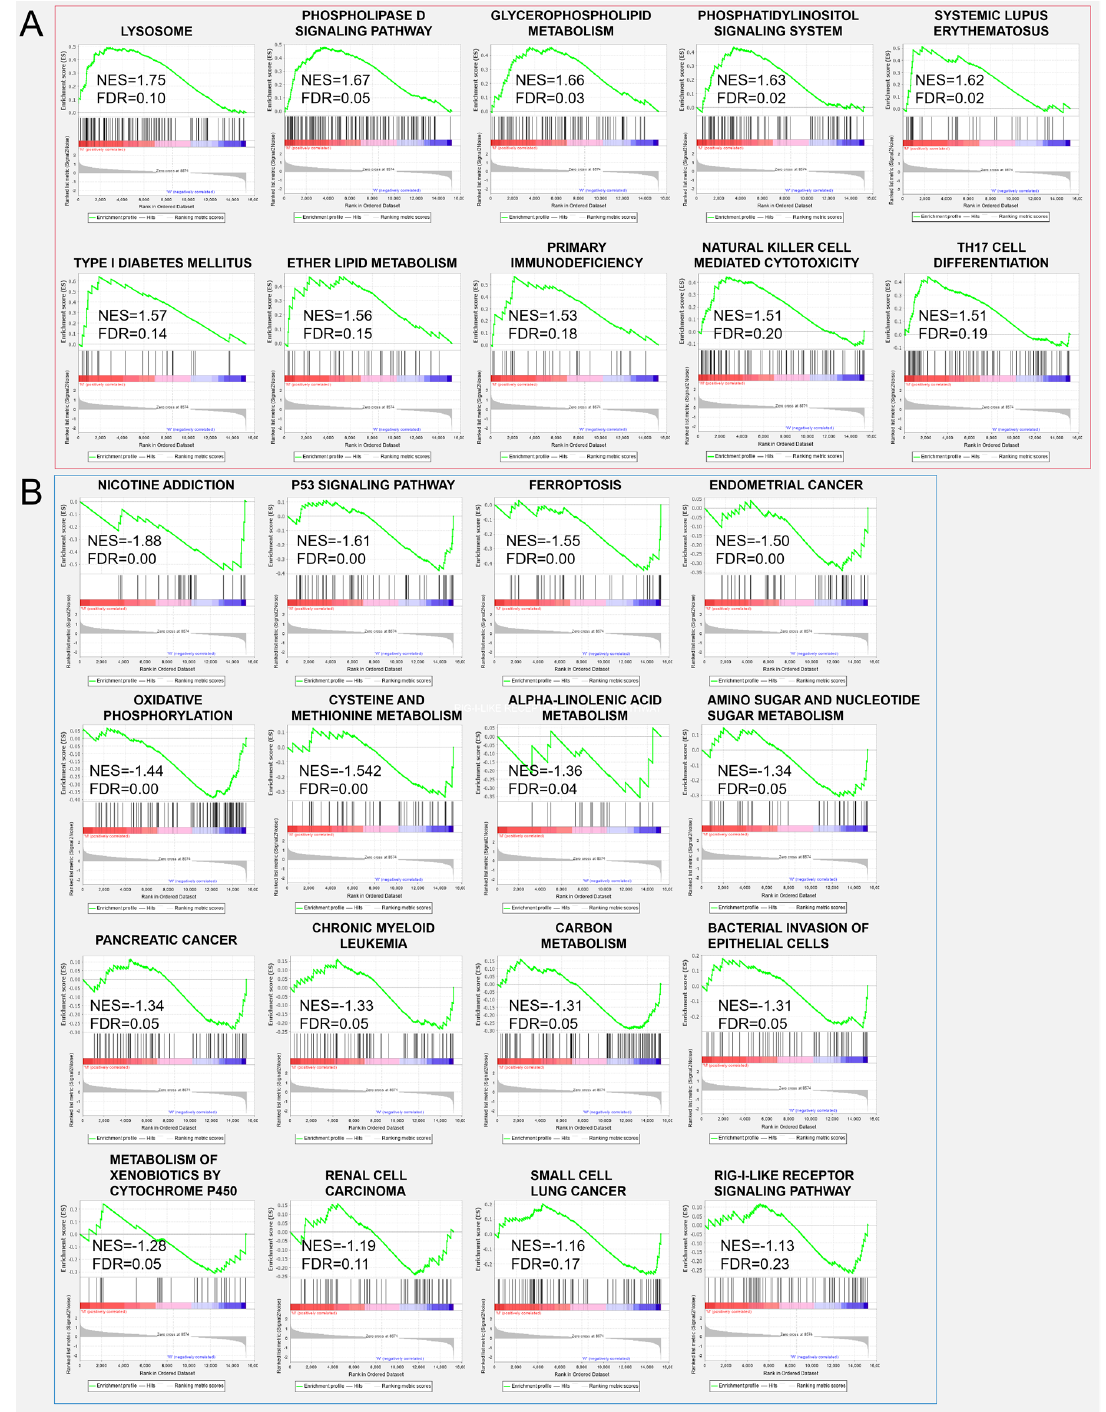
Figure 5. Gene set enrichment analysis (GSEA) analysis between ZBED6 -SKO and WT pig livers ( A ) up-regulated signaling pathway enriched in ZBED6 -SKO pig liver; ( B ) down-regulated signaling pathway enriched in ZBED6 -SKO pig liver. Notes: NES: normalized enrichment score; FDR: false discovery